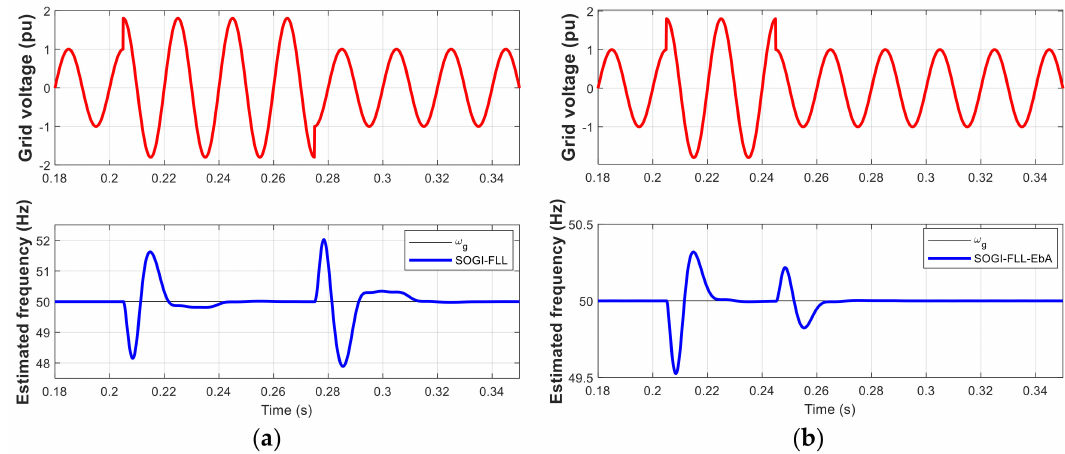
Figure 11. Transient response of the SOGI-FLL and SOGI-FLL-EbA to short-duration voltage swell. ( a ) SOGI-FLL response to a 1.8 pu voltage swell at 0.205 s with three and half cycles of duration. ( b ) SOGI-FLL-EbA response to 1.8 pu voltage swell at 0.205 s with one and half cycles of